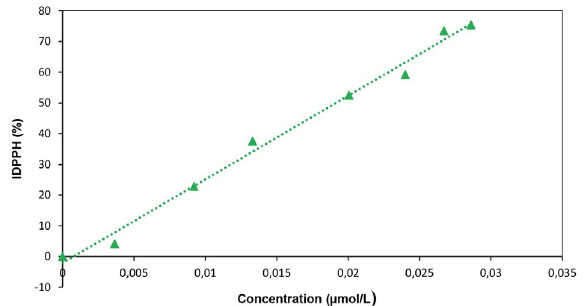
Figure 10. DPPH inhibition percentage curves of the coumarin complex.